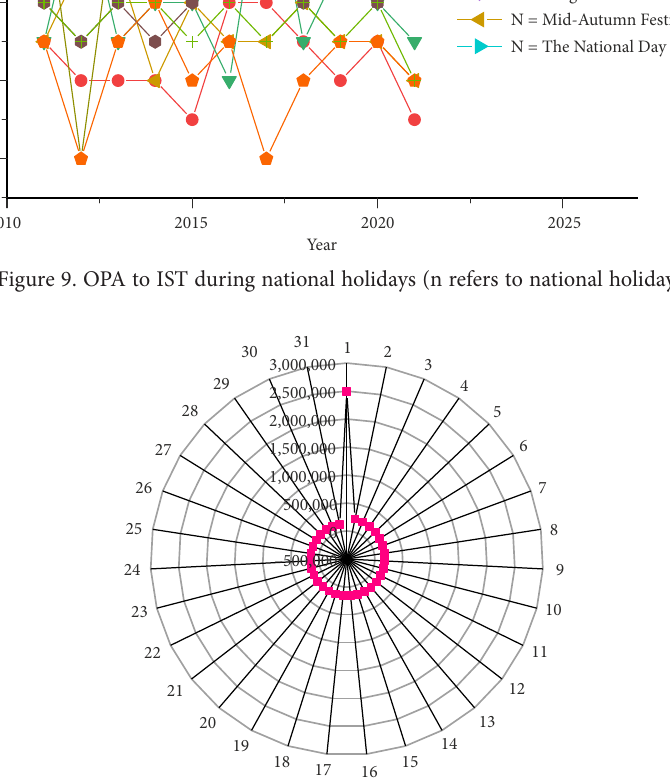
Figure 10. Radar chart of OPA to IST in Harbin from 2011 to